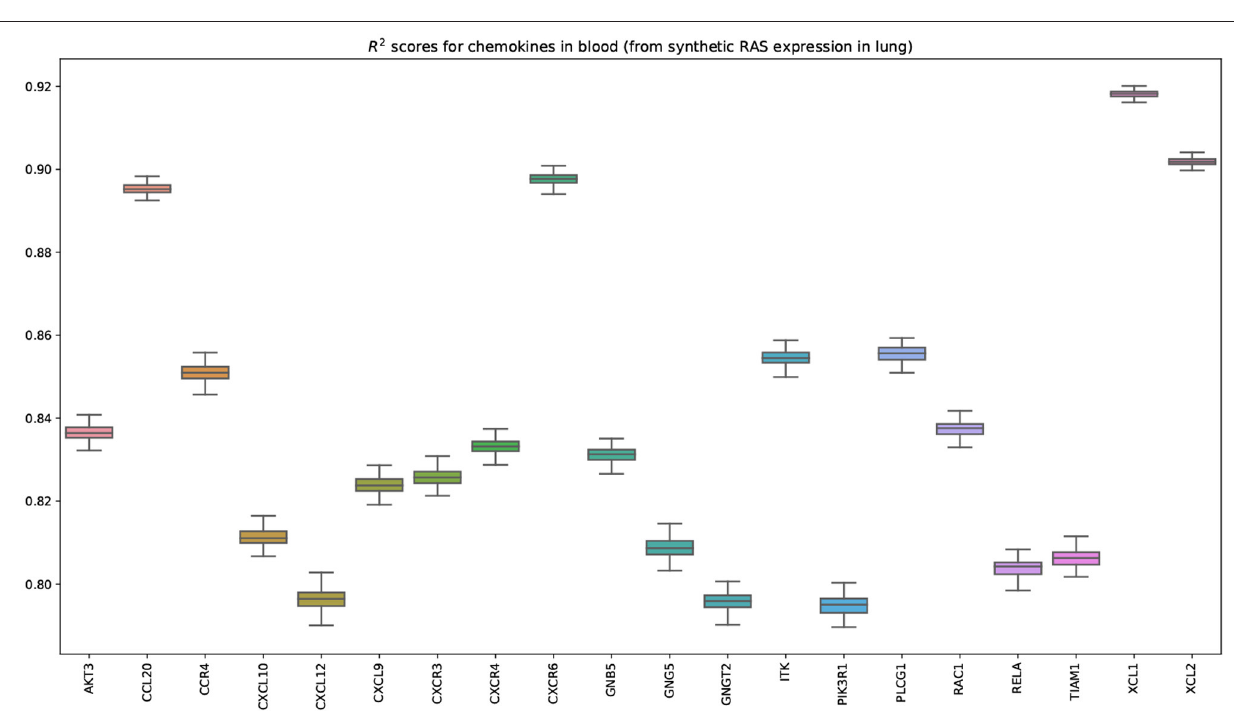
FIGURE 10 | Bootstrapped R 2 scores for chemokines in blood. The input variables are the expressions of 21 genes belonging to the renin-angiotensin system pathway in lung. This plot shows the top 20 predicted chemokines (out of 170). The transcriptomics data was generated by our GAN. Importantly, some of the top predicted chemokines (e.g., CXCR6) have been previously associated with SARS-CoV-2 (Liao et al., 2020).